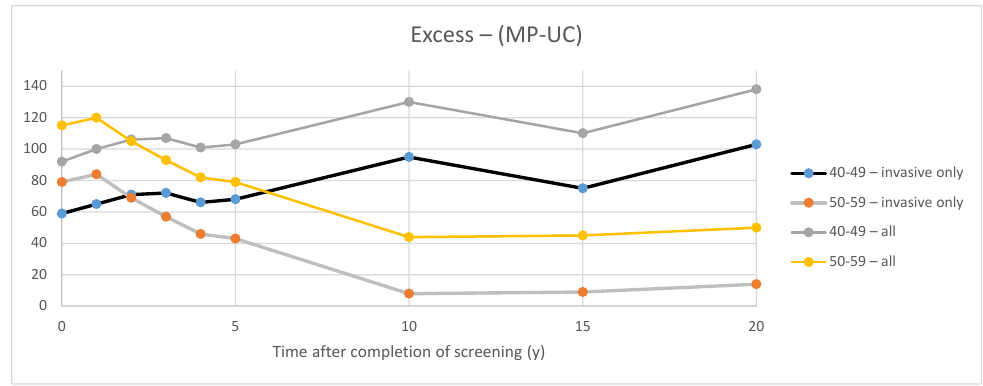
Figure 3. Excess invasive cancers in the study group compared to the controls in the two CNBSS